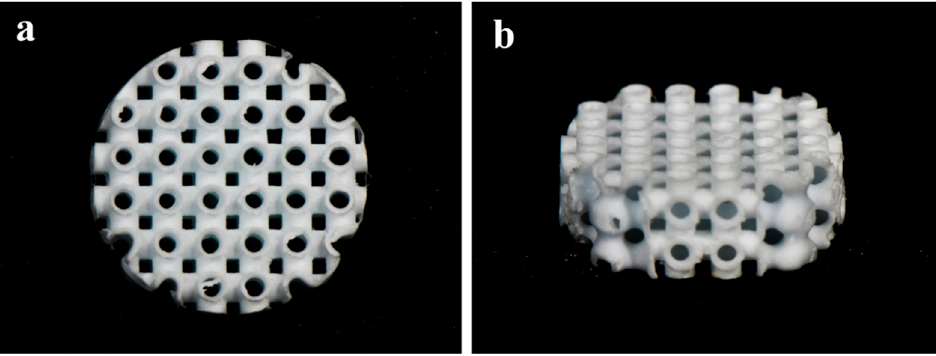
Figure 1. The images of BCP block bone with a 3D hexahedron channel. ( a ) Top view; ( b ) top-side view.